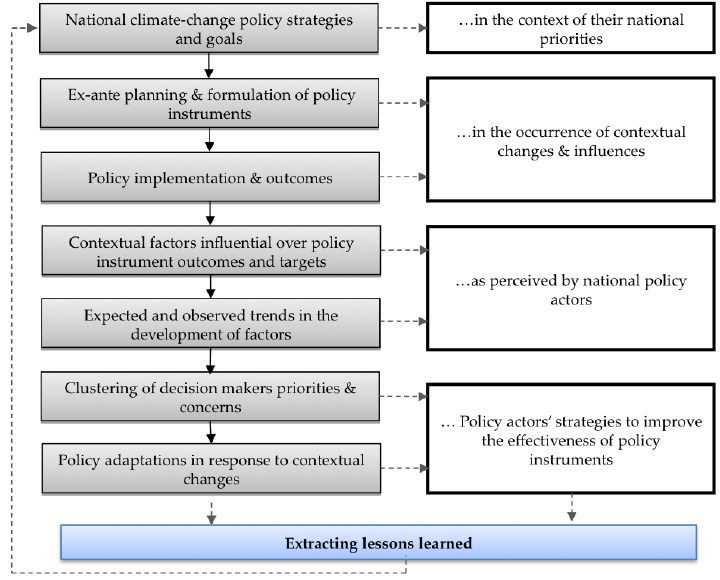
Figure 1. The research framework.